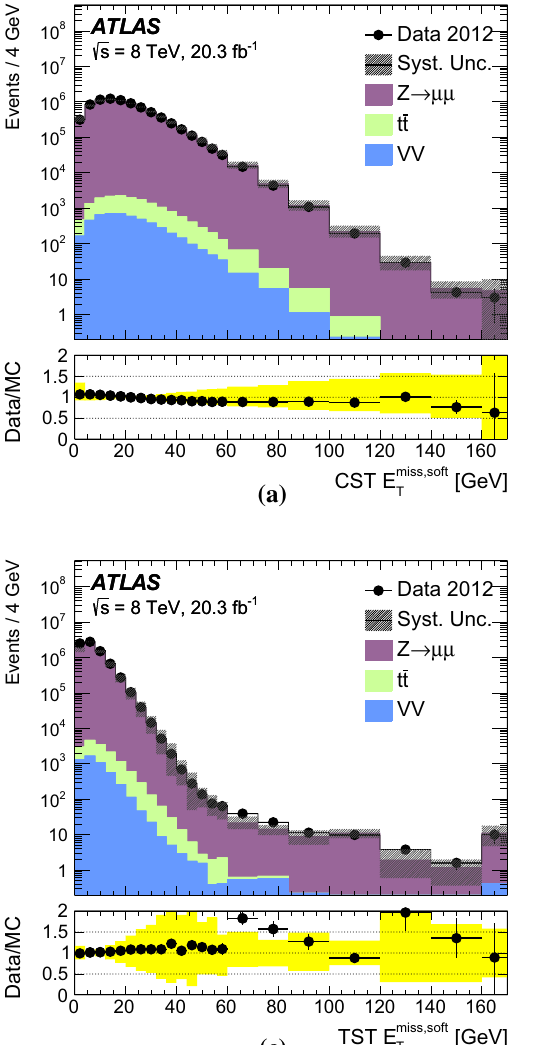
of data to MC simulation, and the bands correspond to the combined systematic and MC statistical uncertainties. The far right bin includes the integral of all events with E miss , soft